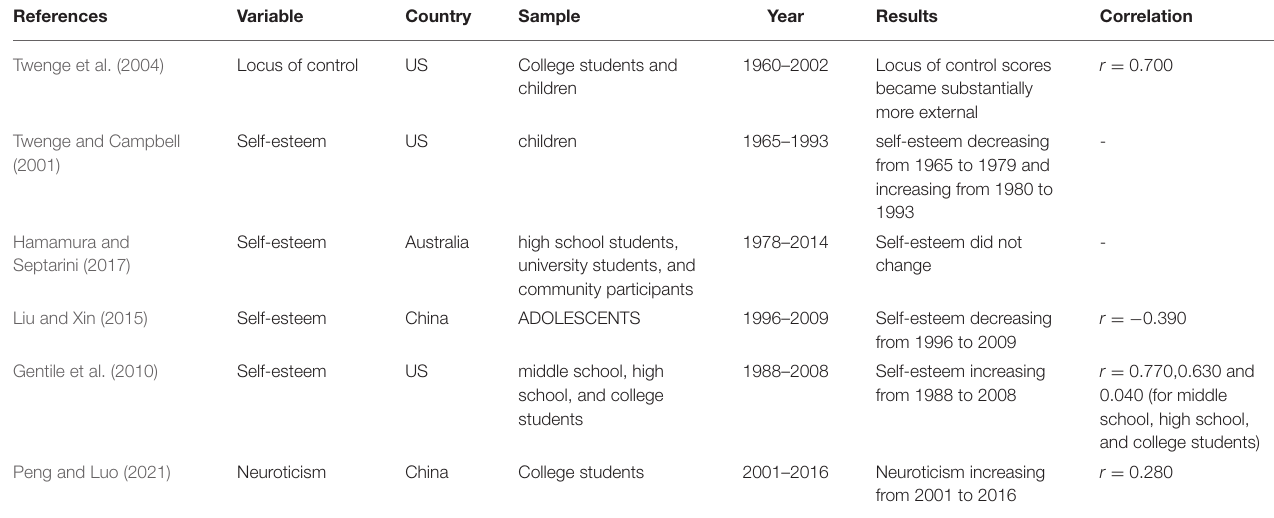
TABLE 1 | Previous cross-temporal meta-analyses of